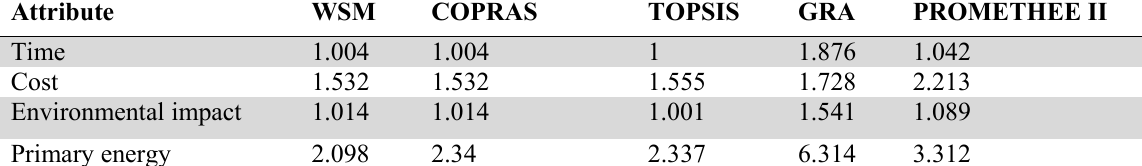
Sensitivity measures of different attributes for different multi-criteria decision making techniques Attribute